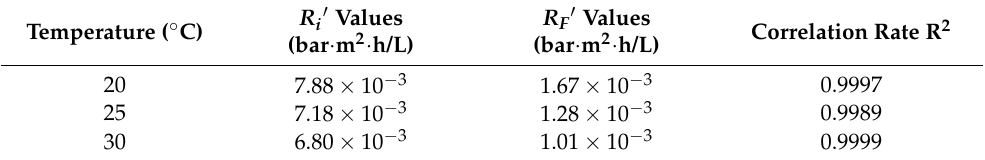
Table 4. Total resistance and fouling resistance of the membrane at different temperatures after